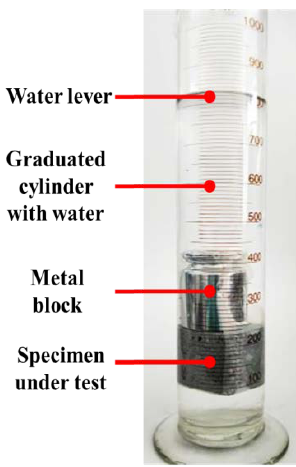
Figure 3. Determination of the water absorption of the foam concrete.